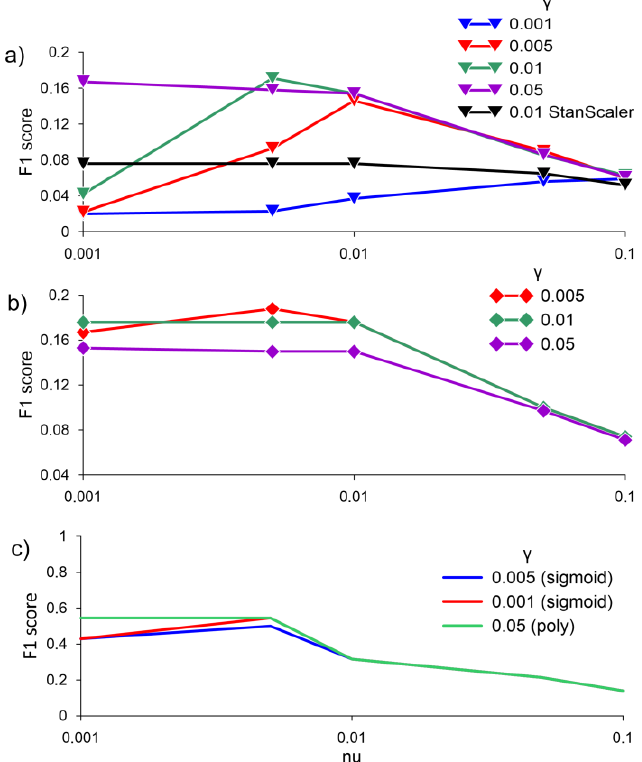
Figure 6. F1 score for ( a ) averaging data over 30 min, MinMaxScaler, and StandardScaler, with RBF; ( b ) averaging data over 30 min, without RBF scale; ( c ) with two kernels — sigmoid and poly, without ( b ) averaging data over 30 min, without RBF scale; ( c ) with two kernels—sigmoid and poly, without scale at different values of γ, obtained by the one-class SVM algorithm. scale at different values of γ , obtained by the one-class SVM